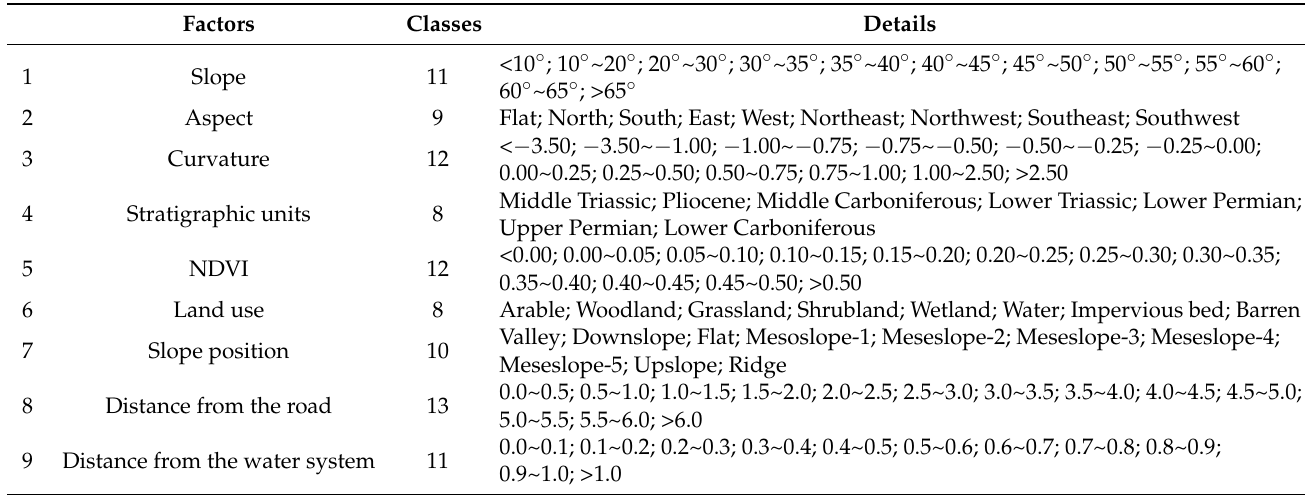
Table 2. Detailed information of landslide causative